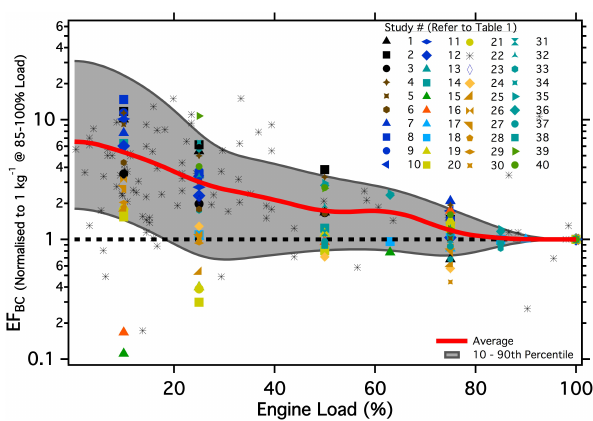
Fig. 2. The relationship between EF BC and ship engine load. Aver- age=red, 10th and 90th